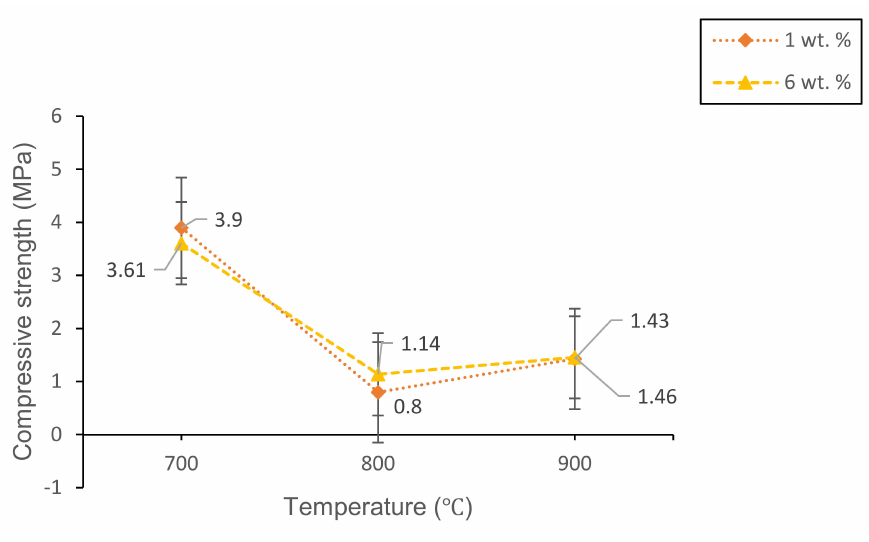
Figure 12. The compressive strength of 1 and 6 wt% samples sintered at various temperatures for 60